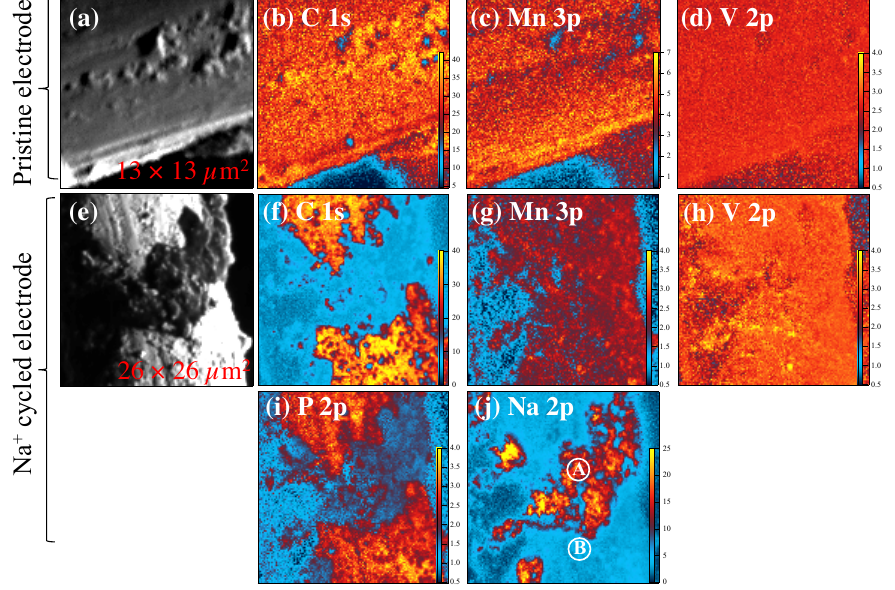
Figure 4. Scanning X-ray photoelectron microscopy (SPEM) maps of pristine ( a – d ) and Na + cycled ( e – j ) MVO-CNTs electrodes, respectively, for selected elements. The color scale bar in each chemical SPEM map is representing the relative chemical concentration for the selected elements. The maps in gray color ( a , e ) are the raw SPEM maps before eliminating topographic